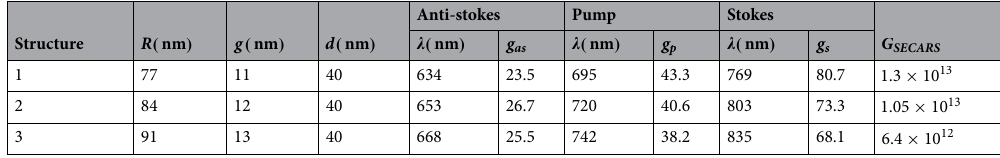
Table 1. Evaluation of the SECARS EF with the different configuration parameters where radius to gap ratio is considered to be constant and equal to 7.